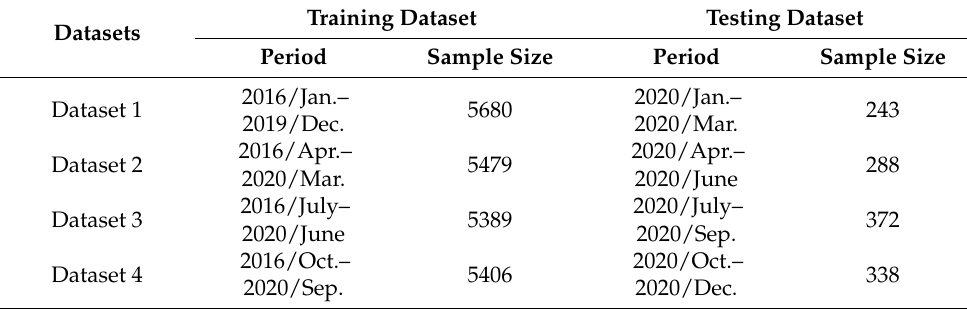
Table 1. The dataset design for the